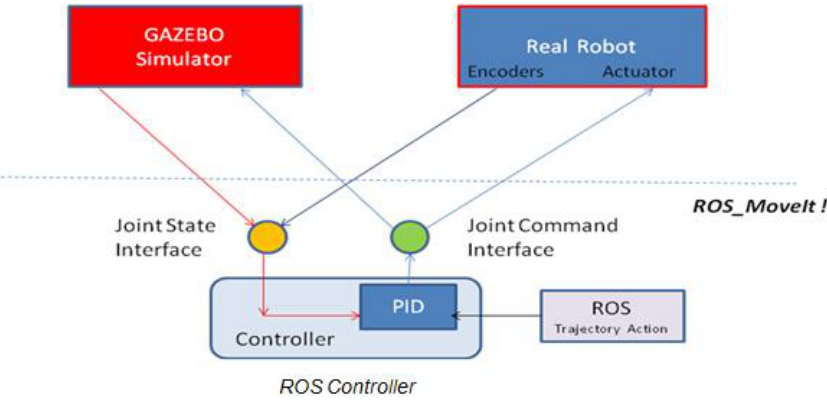
Figure 8. Structure of a ROS controller.